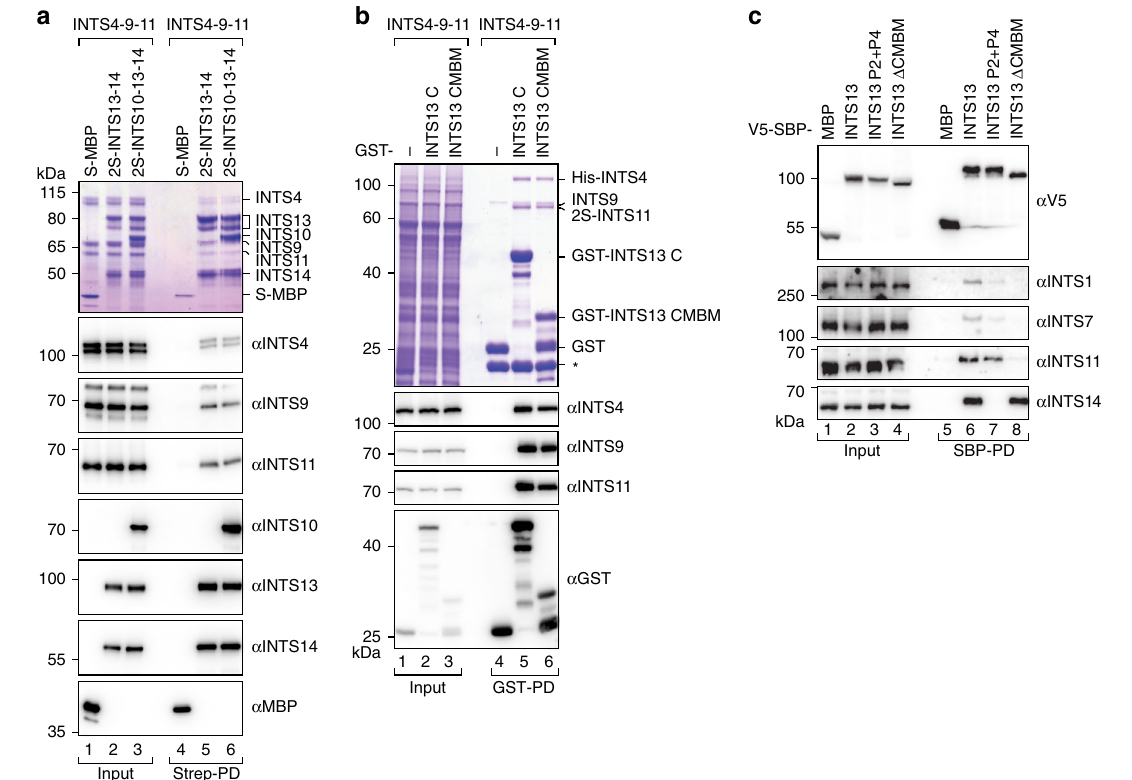
Fig. 5 INTS10 – INTS13 – INTS14 binds the INT cleavage module via a conserved motif in the INTS13 C-terminus. a Coomassie-stained gel and corresponding Western blots from copuri fi cation of the INT cleavage module (INTS4 – INTS9 – INT11) with 2S-INTS13 – INTS14 or 2S-INTS10 – INTS13 – INTS14 using puri fi ed complexes. S-MBP served as negative control. b Coomassie stained gel and corresponding Western blots from copuri fi cation of INT cleavage module from insect cell extracts with GST-INTS13 C-term constructs from E.coli lysates. GST served as negative control. The asterisk marks endogenous GST from insect cells that also binds to GSH-beads. c Coprecipitation of endogenous INT subunits with V5-SBP-INTS13 wild type and mutants. V5-SBP- MBP is included as a control. Inputs ( α V5-blot 1%, α INTS14 0.5%, and others 0.1%) and bound fractions ( α V5-blot 5%, α INTS14 10%, and others 20%) were analyzed by Western